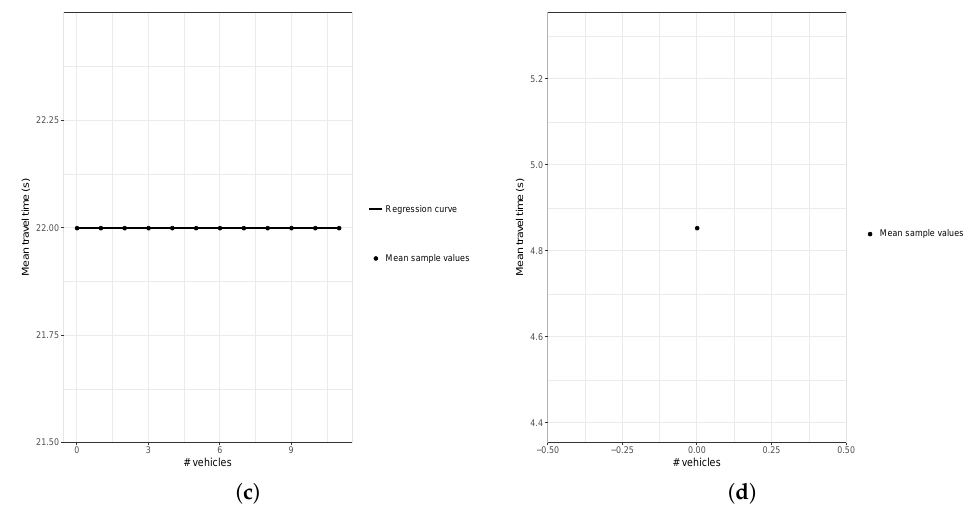
Figure 4. Segment Classification with uniform traffic load regulation: ( a ) increasing; ( b ) behavior of a segment previously showing a decreasing behavior; ( c ) constant; and ( d )